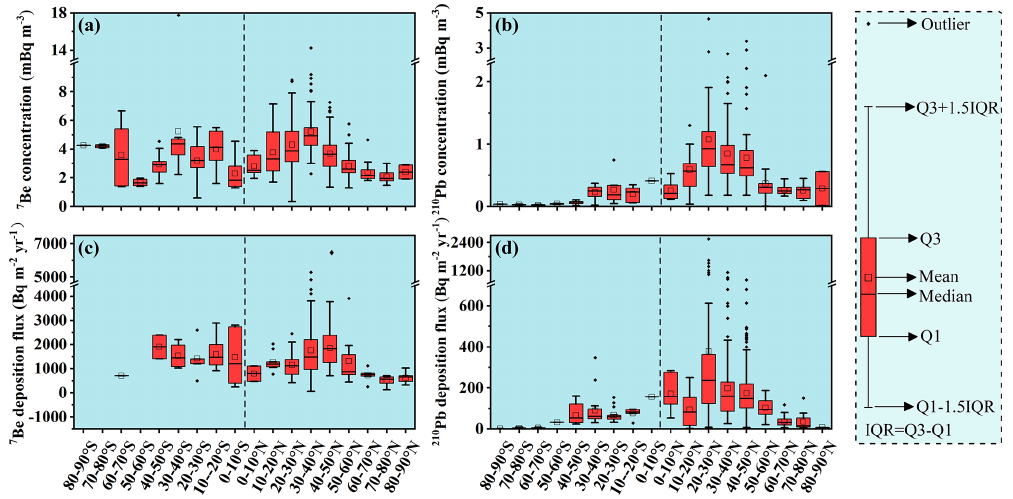
Figure 5. Latitudinal variability (box and whisker plots) of (a) 7 Be concentration, (b) 210 Pb concentration, (c) 7 Be depositional flux, and (d) 210 Pb depositional flux plotted by 10 ◦ latitudinal